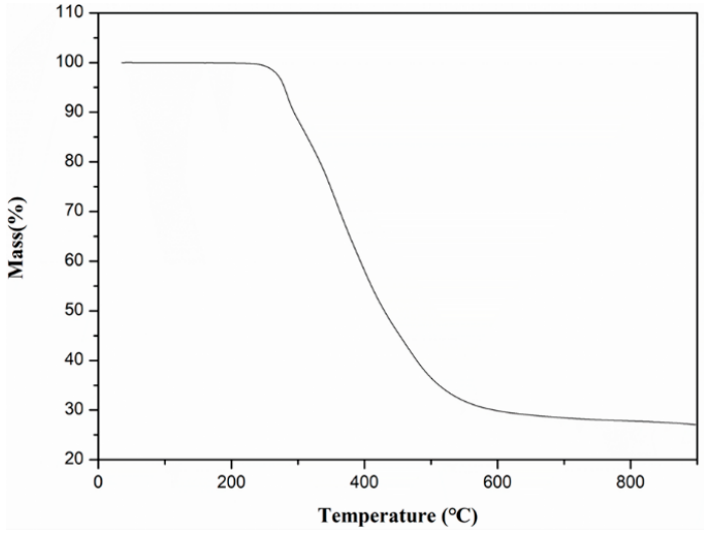
Figure 4. TGA curve of PSCTLCP.